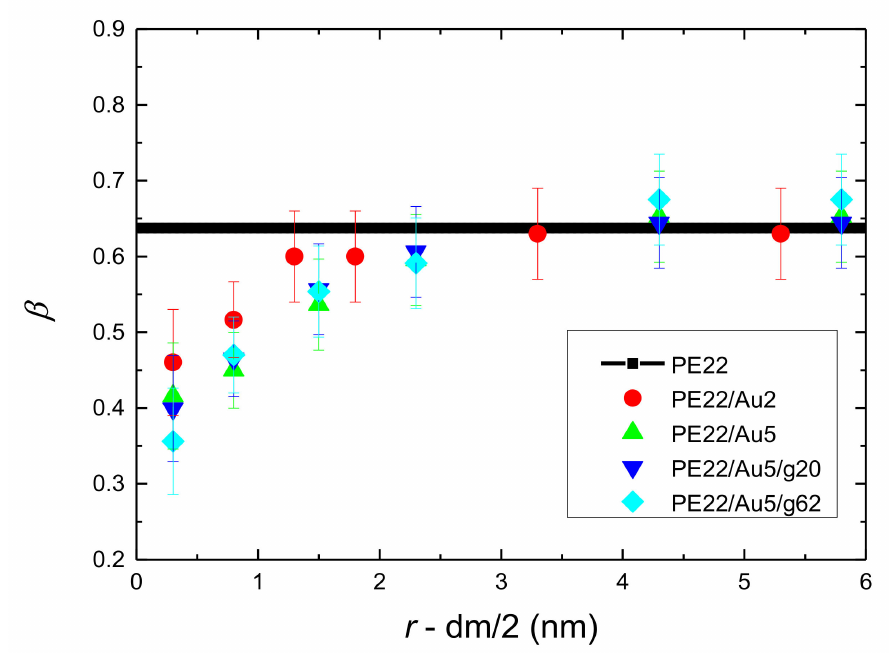
Figure A10. The stretch exponent β , as extracted from the fit of C 1–3 ( t ) ACF with a KWW, as a function of distance from the center of the Au NP, r , minus the half diameter of the NP, for all systems with PE matrices consisting of 22 mers per chain. Black lines represent β values of bulk